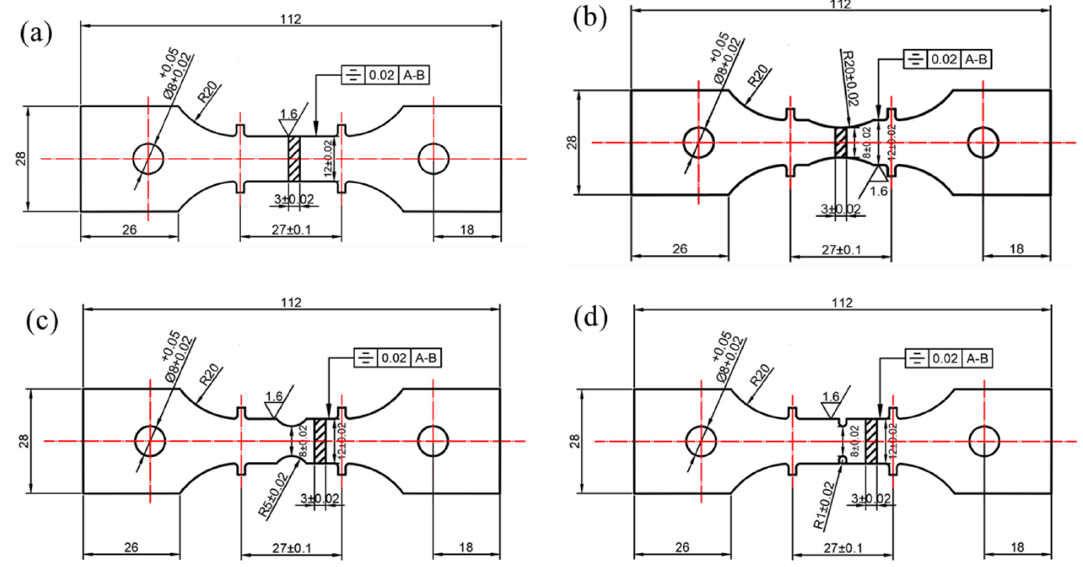
Figure 2. Tensile specimens: ( a ) Unnotched specimen; ( b ) Notched specimen (R = 20 mm); ( c ) Notched specimen (R = 5 mm); ( d ) Notched specimen (R = 1 mm).